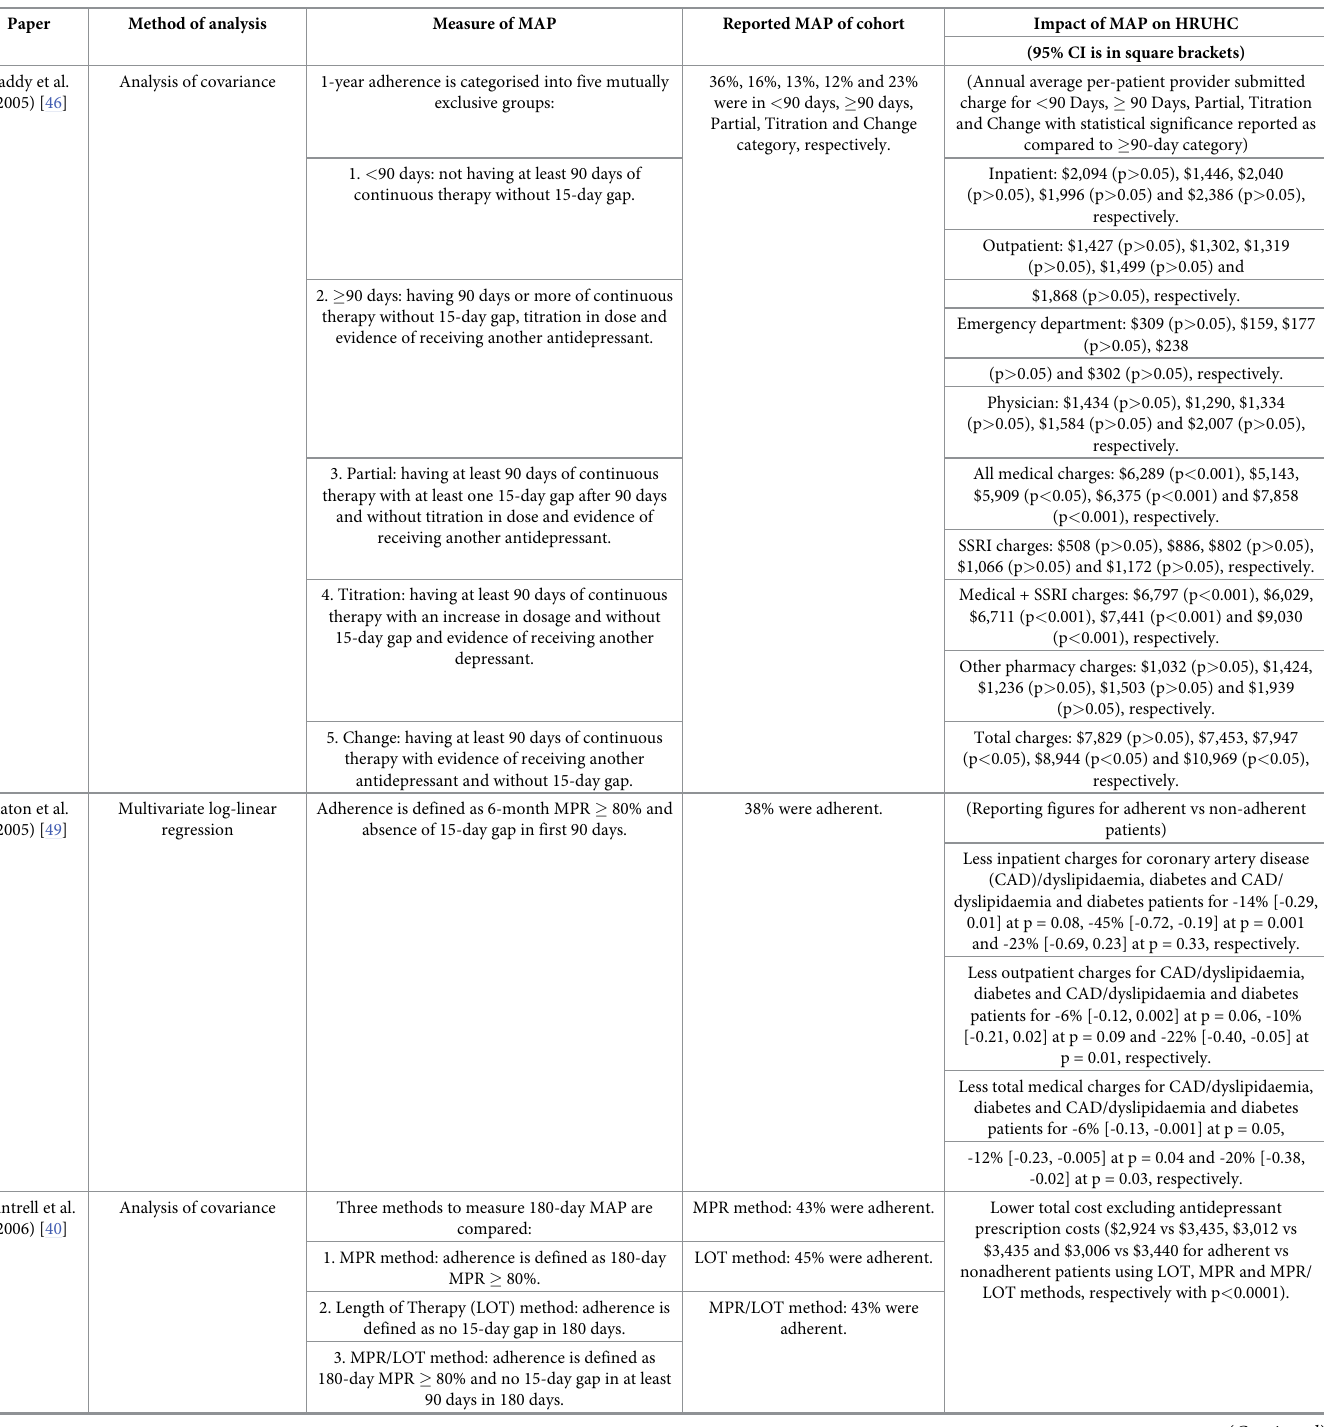
Table 6. Impact of adherence or persistence to antidepressants on healthcare resource utilisations and healthcare costs.